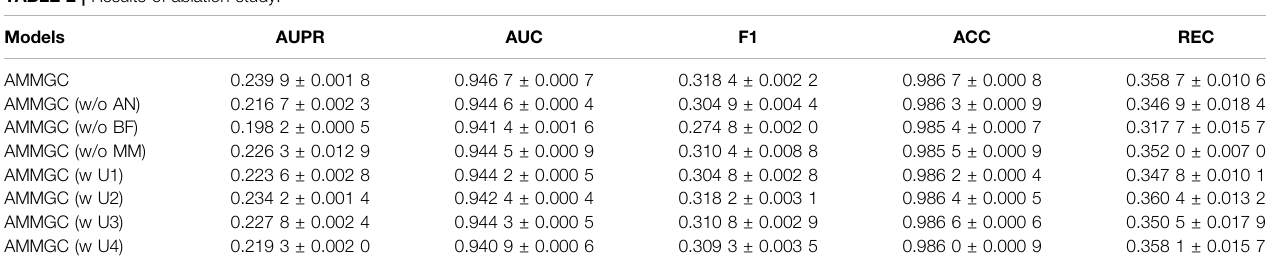
TABLE 2 | Results of ablation study.